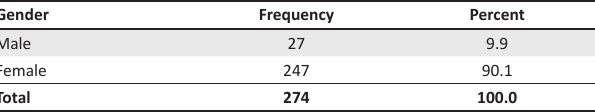
TABLE 3: Frequency table showing the gender of respondents in the